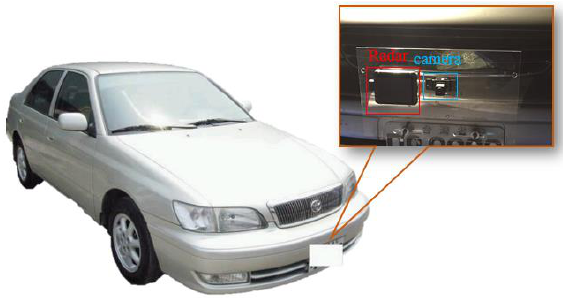
Figure 11. Experimental car and sensors setup.